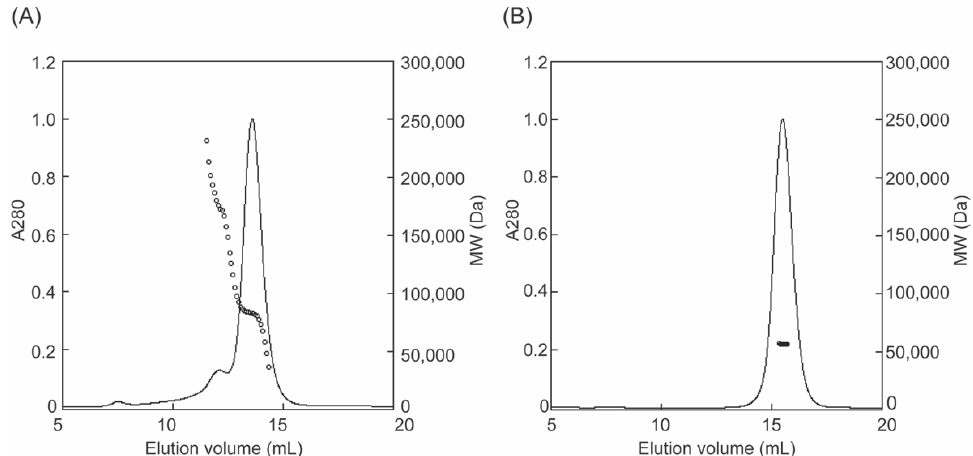
Figure 4. Molecular weight (MW) determination of LOXL2 by SEC-MALS ( A ) fl-LOXL2 ( B ) Δ 1- 2SRCR-LOXL2; for clarity only every 10th measurement of MW is plotted.